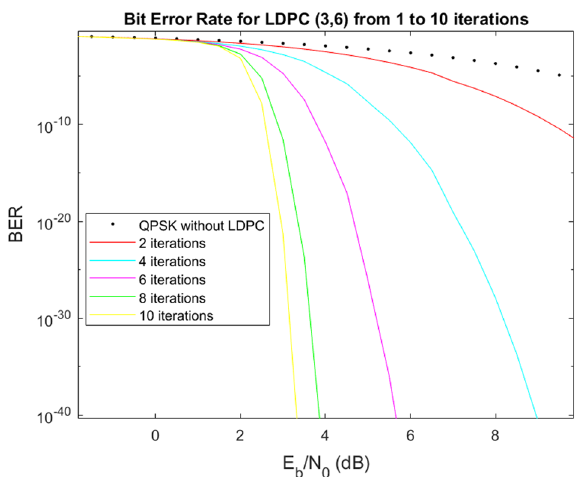
Fig. 6 BER versus SNR for different iterations loop of a regular